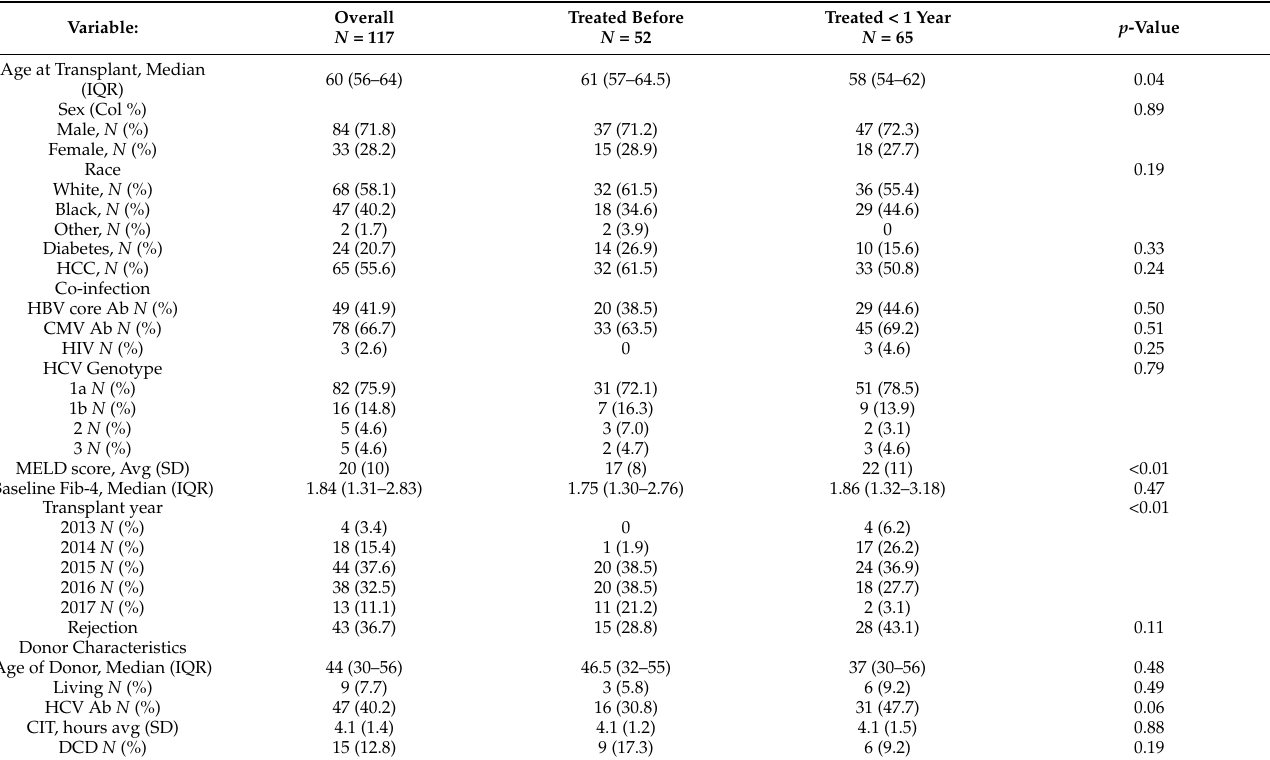
Table 1. Liver transplant recipient and donor clinical characteristics by treatment group, overall N =